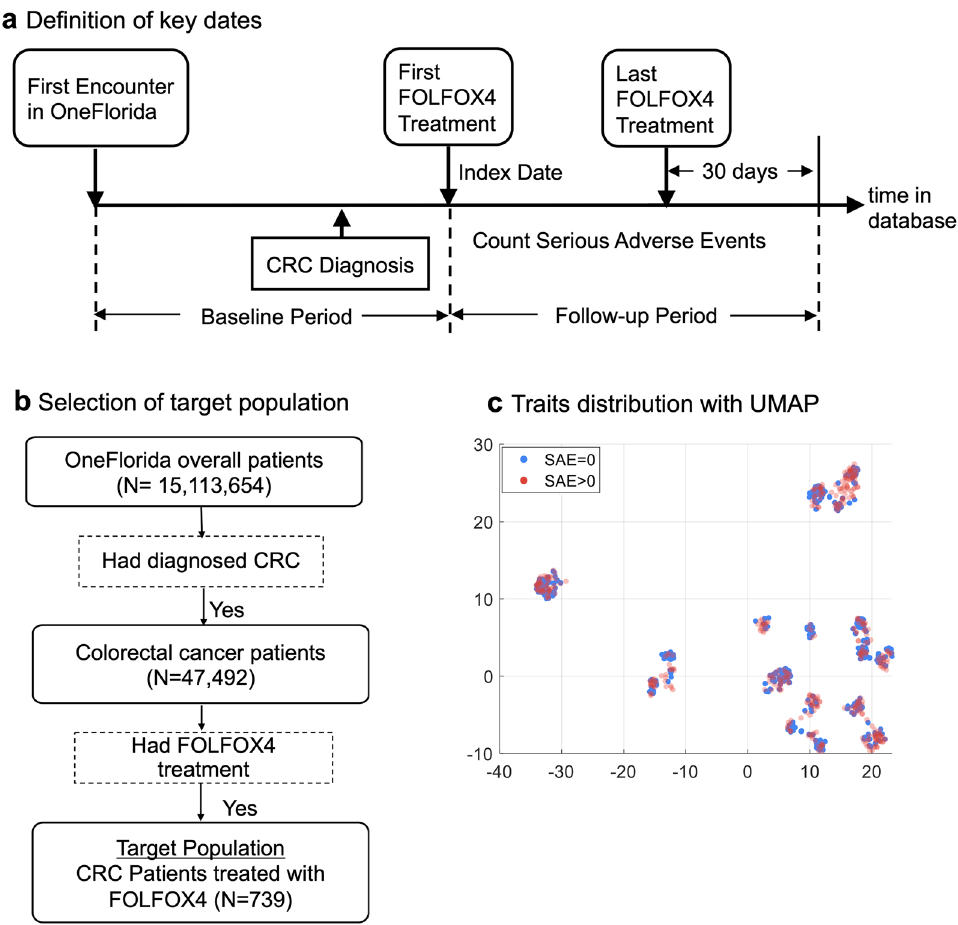
Figure 3. Bevacizumab clinical trial. ( a ) Definition of key dates. ( b ) Selection of target population. Each sample is colored based on whether the patient had SAEs or not. ( c ) Traits distribution with